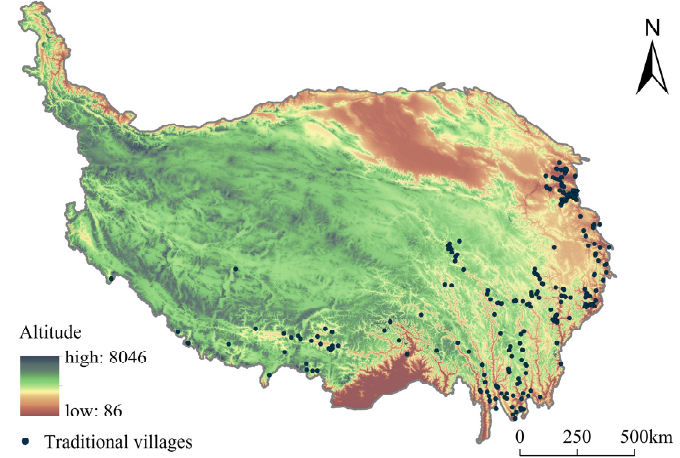
Figure 8. Altitudes of traditional villages coupled with altitude on the Tibetan Plateau.